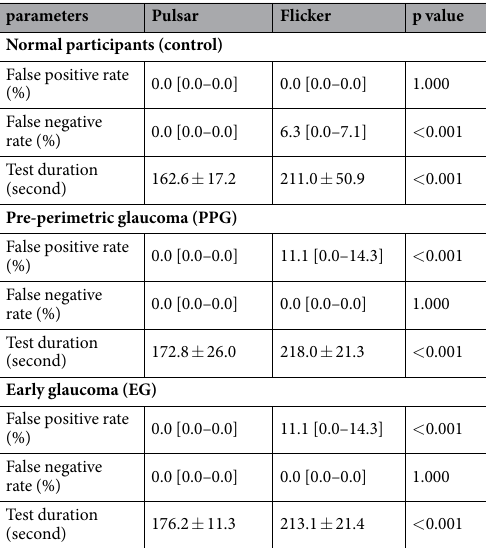
parameters Pulsar Flicker p value